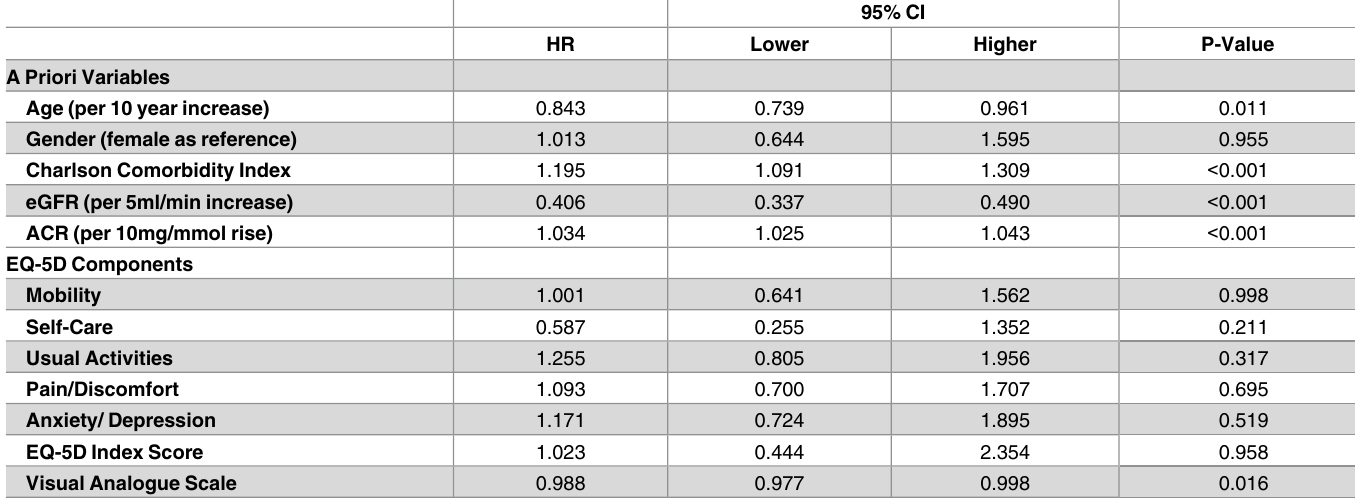
Table 6. Univariable Survival Analyses(Cox regression) for hazard ratio (HR) for End-stage Renal Disease(ESRD). A priori variables and all compo- nents of EQ-5D shown.